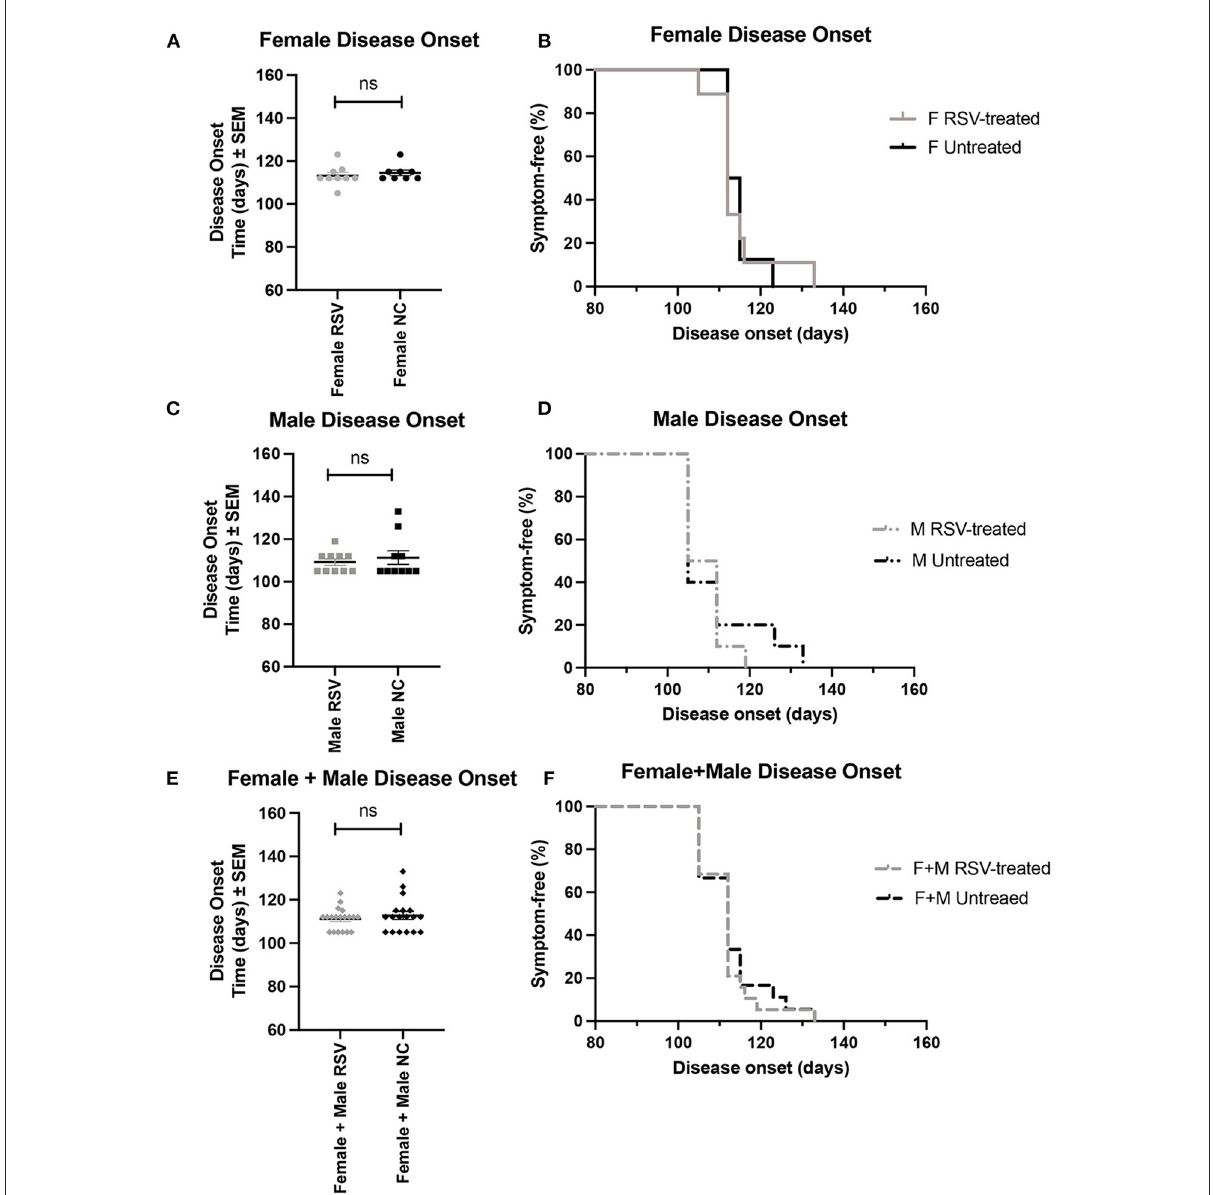
FIGURE1 Scatter plots and Kaplan-Meier curves showing disease onset for female, male, and combined (female + male) RSV-treated vs. untreated ALS mice. Disease onset was determined as the time of the first recorded MS = 3. (A) Female disease onset scatter plot. (B) Female disease onset Kaplan-Meier plot. (C) Male disease onset scatter plot. (D) Male disease onset Kaplan-Meier plot. (E) (Female + male) disease onset scatter plot. (F) (Female + male) disease onset Kaplan-Meier plot. RSV, Resveratrol-treated animals; NC, Untreated animals received normal chow. Data in panels (A, C, E) are expressed as mean ± SEM. ns,